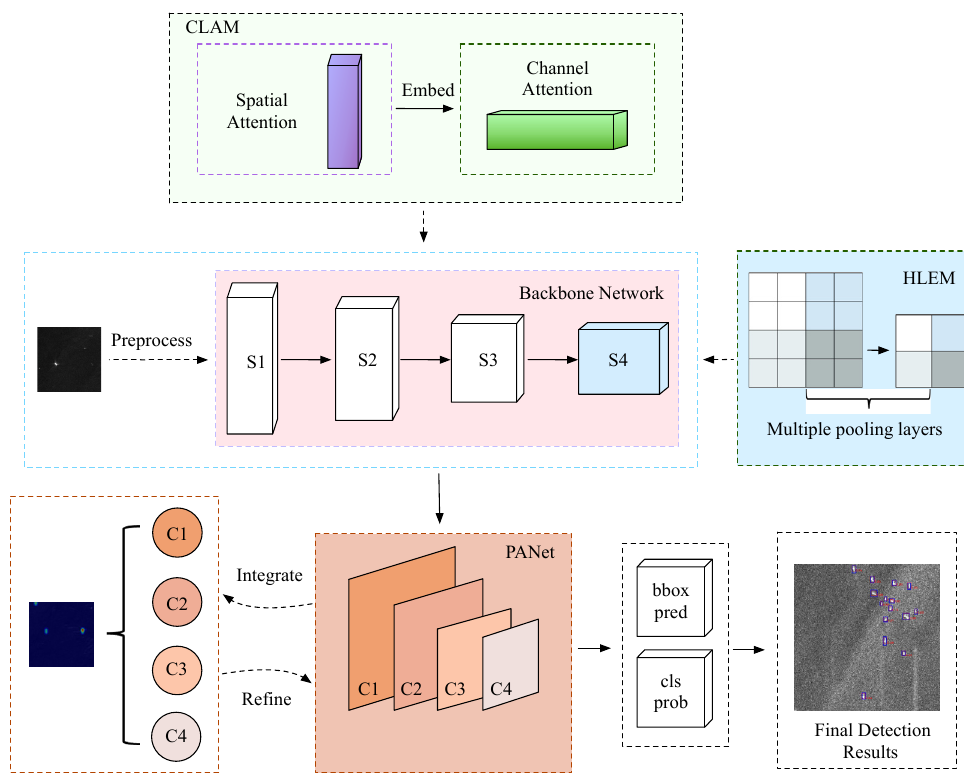
Figure 2. Overall framework of SII-Net.